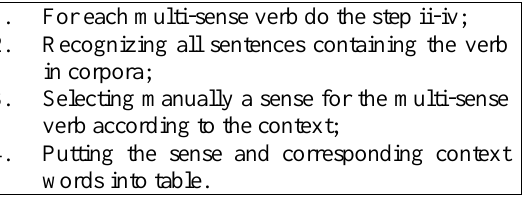
Figure 1. Pseudocode of decision table generation